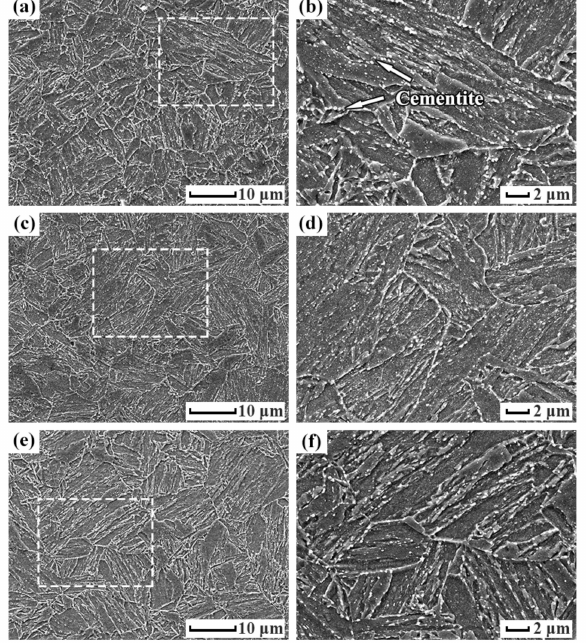
Figure 3. SEM micrographs of the 0.5Cr0.4W steels tempered at ( a ) 690 ◦ C, ( c ) 700 ◦ C, and ( e ) 715 ◦ C, ( b , d , f ) are higher magnification SEM images of ( a , c , e ), respectively.